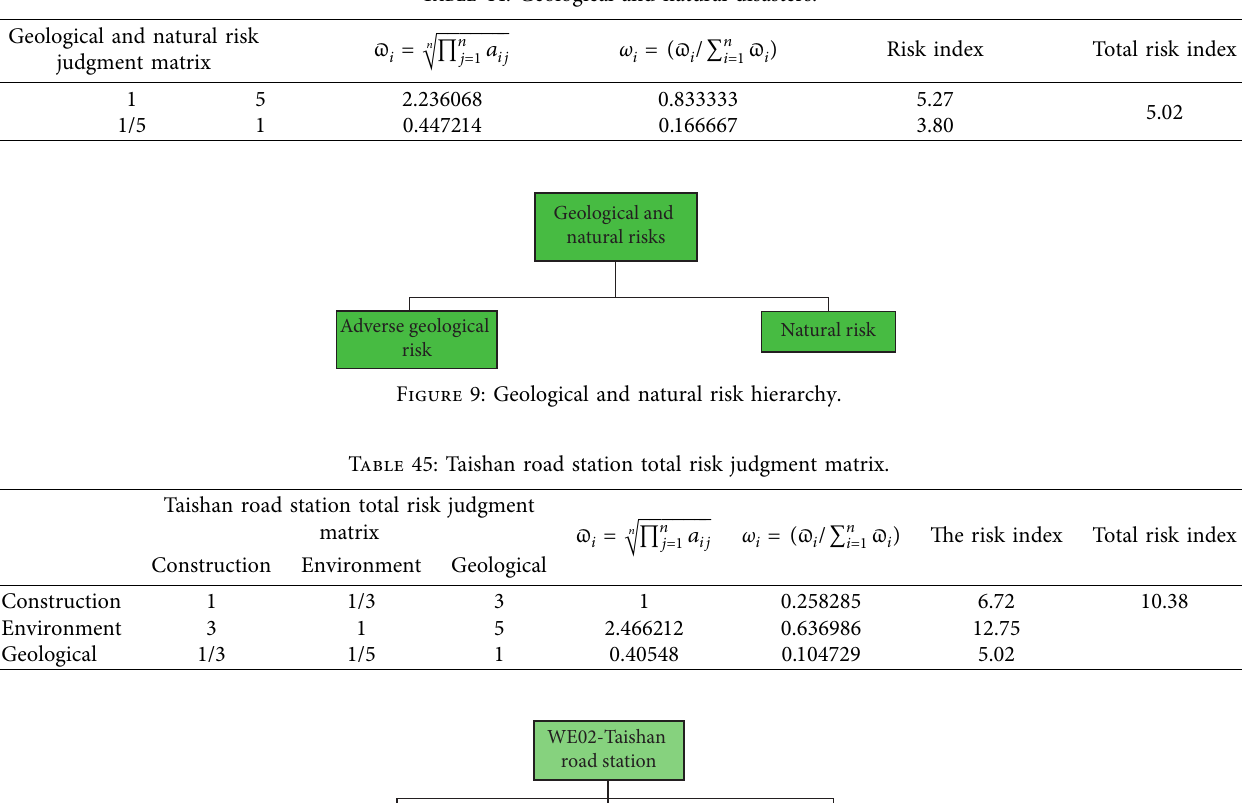
Table 44: Geological and natural disasters.